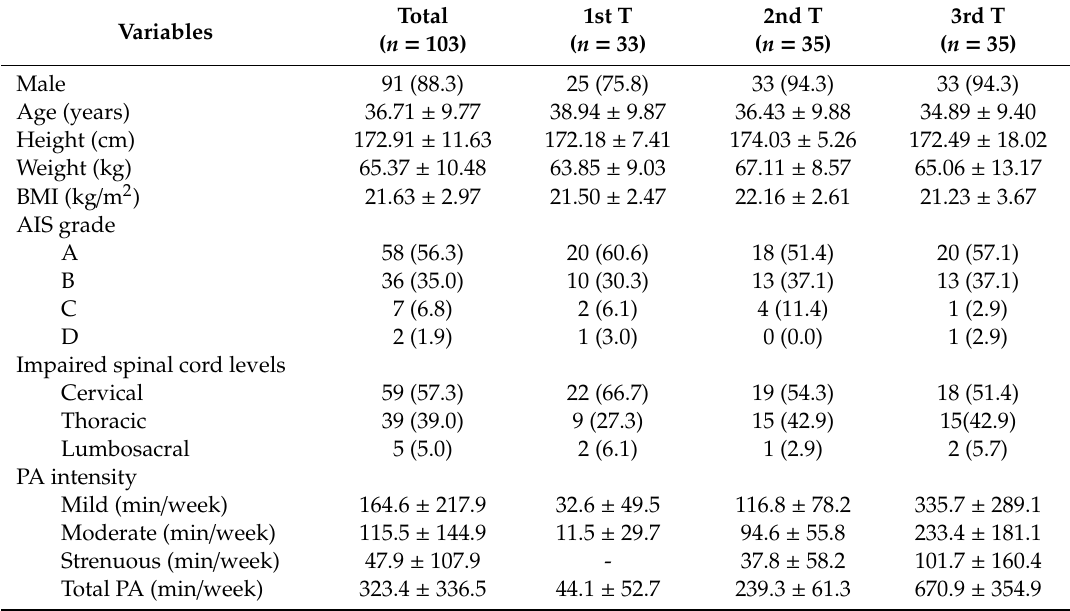
Table 1. Characteristics and physical activity profile of participants with spinal cord